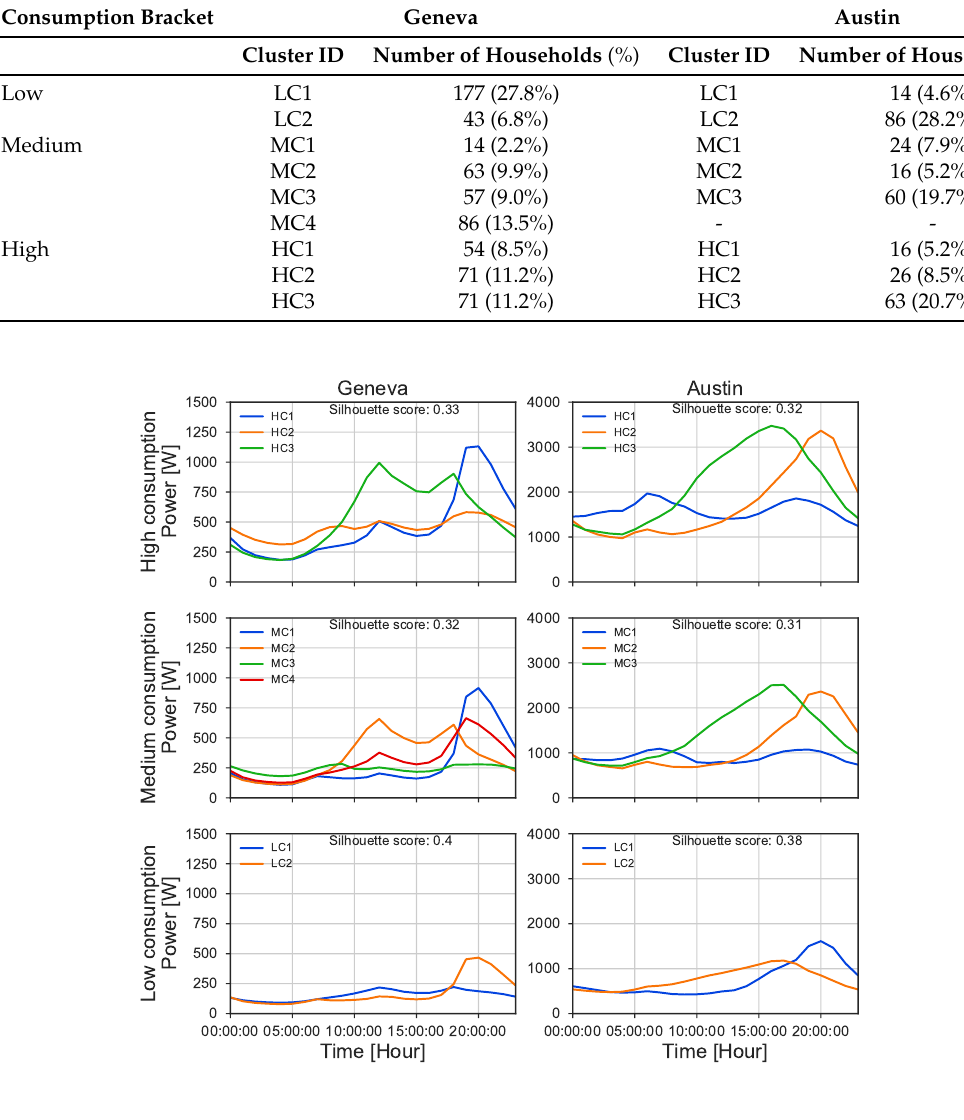
Figure 4. Centroids of the various clusters found for daily electricity profiles with their average silhouette score for each sub-group and location. Note that the scale of the vertical axis differs for Geneva and